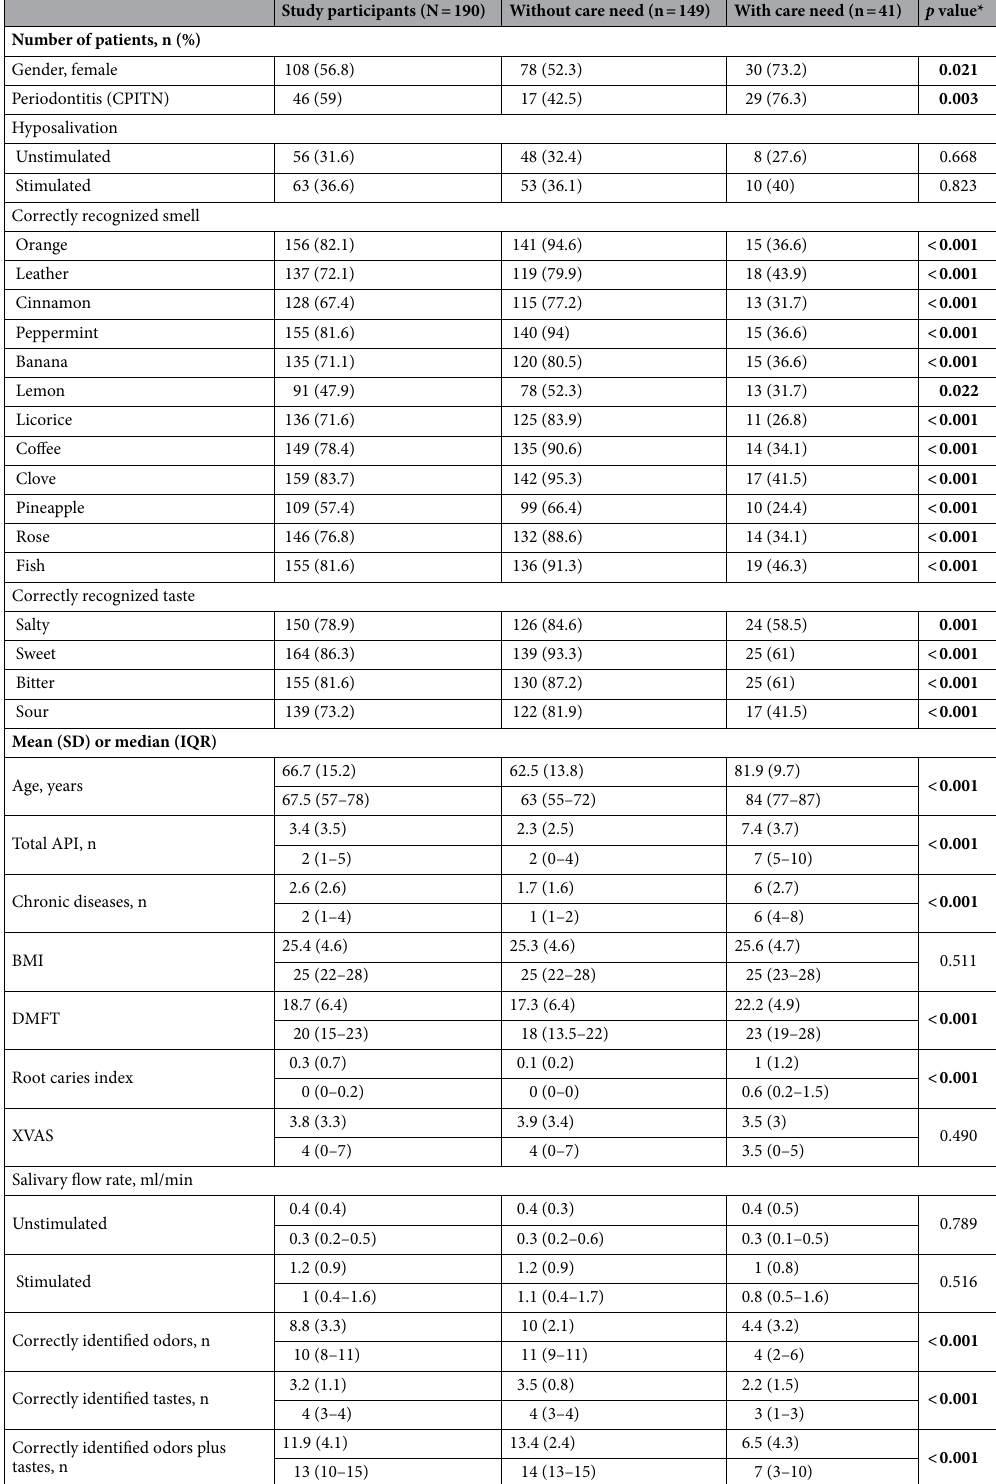
Table 4. Identification of smells (Sniffin’ Sticks) and tastes (taste strips) according to care need (nursing grade). API active pharmaceutical ingredients, BMI body mass index, CPITN community periodontal index of treatment needs, DMFT decayed missed filled teeth, IQR interquartile range, SD standard deviation, XVAS xerostomic visual analog scale. * p < 0.05 indicates statistical significance (bold numbers), evaluated using Fisher’s Exact Test or Mann–Whitney U